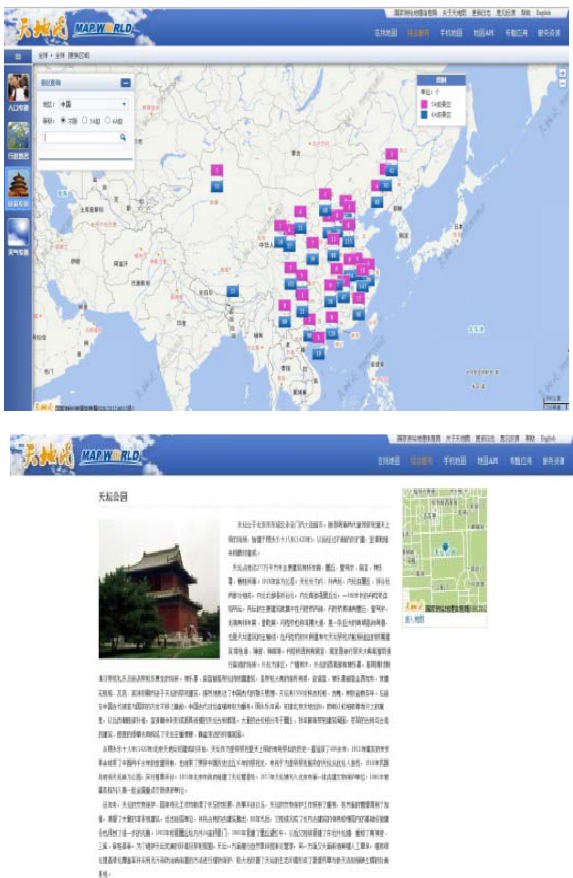
Figure 3: Search Results of TIANDITU for